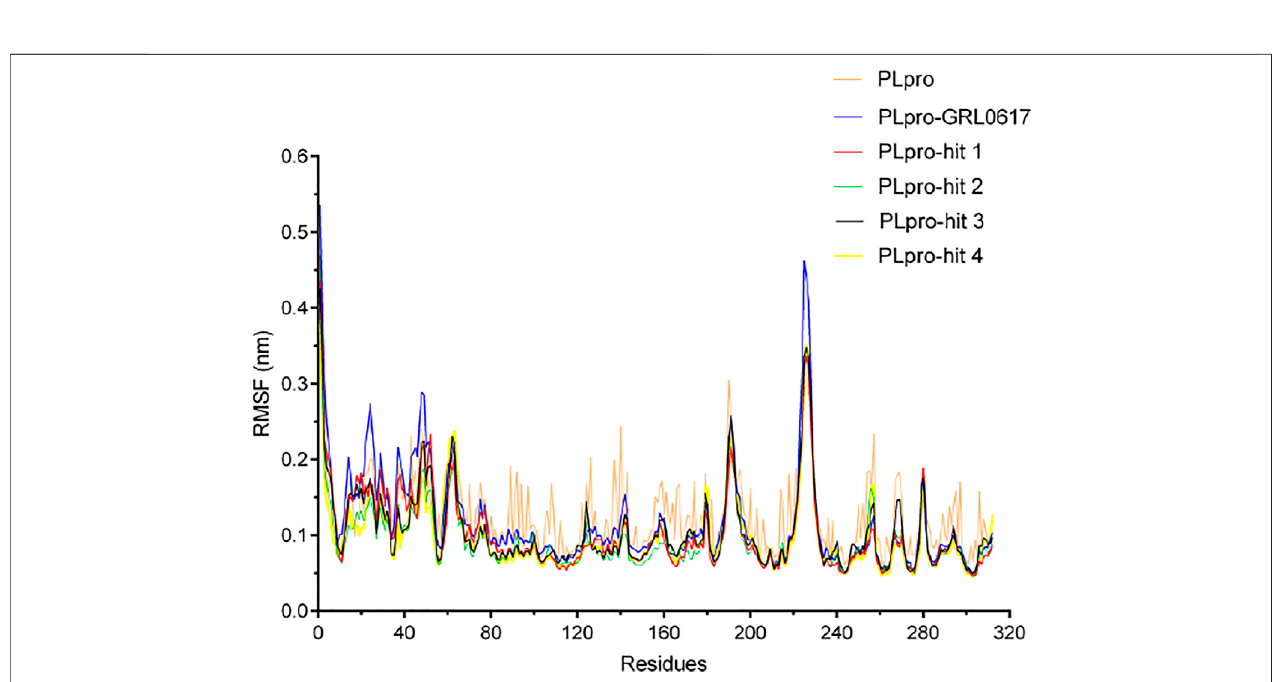
FIGURE 5 | The root mean square fl uctuation (RMSF) of PLpro alone and PLpro complex with GRL0617, hit 1, hit 2, hit 3, and hit 4 over the time scale of 50 ns.